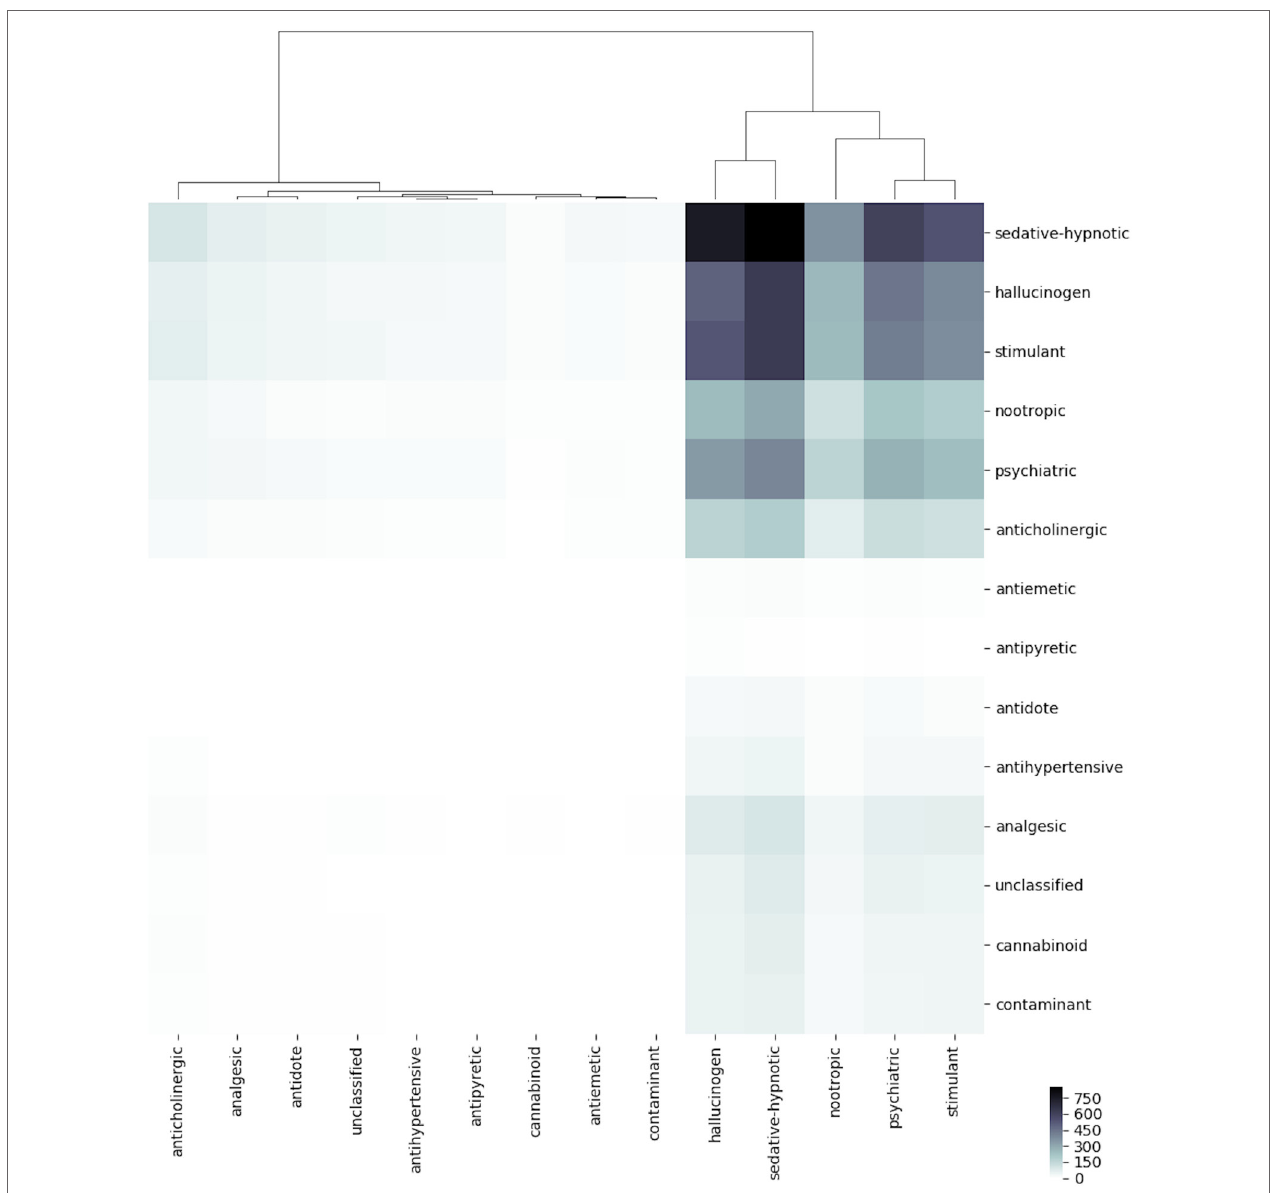
FigUre 3 | Heat map of substance-substance co-mentions by class. Each tiny box represents one pair of substance classes. Labels on the x - and y -axes specify the substance classes associated with each box. Color of tiny box indicates absolute frequency of mentions, according to colorbar scale in lower